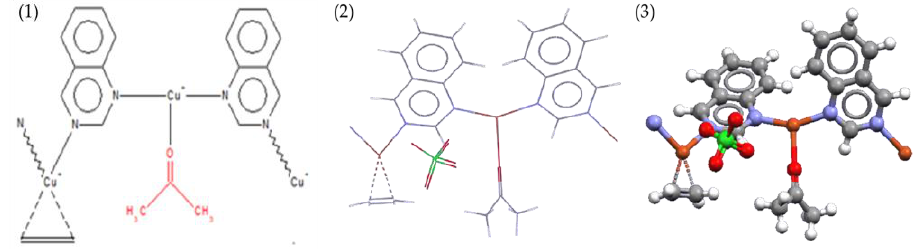
Figure 3. Image of referenced CCDC data (Refcode: HECYUJ, ( 1 ): 2D image, ( 2 ): 3D image, ( 3 ): 3D image).